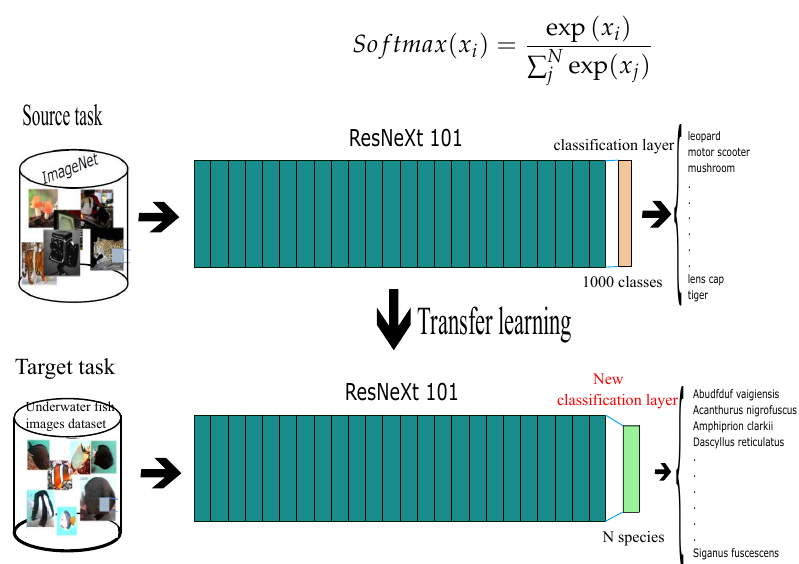
Figure 3. The proposed method for fish recognition based on transfer learning